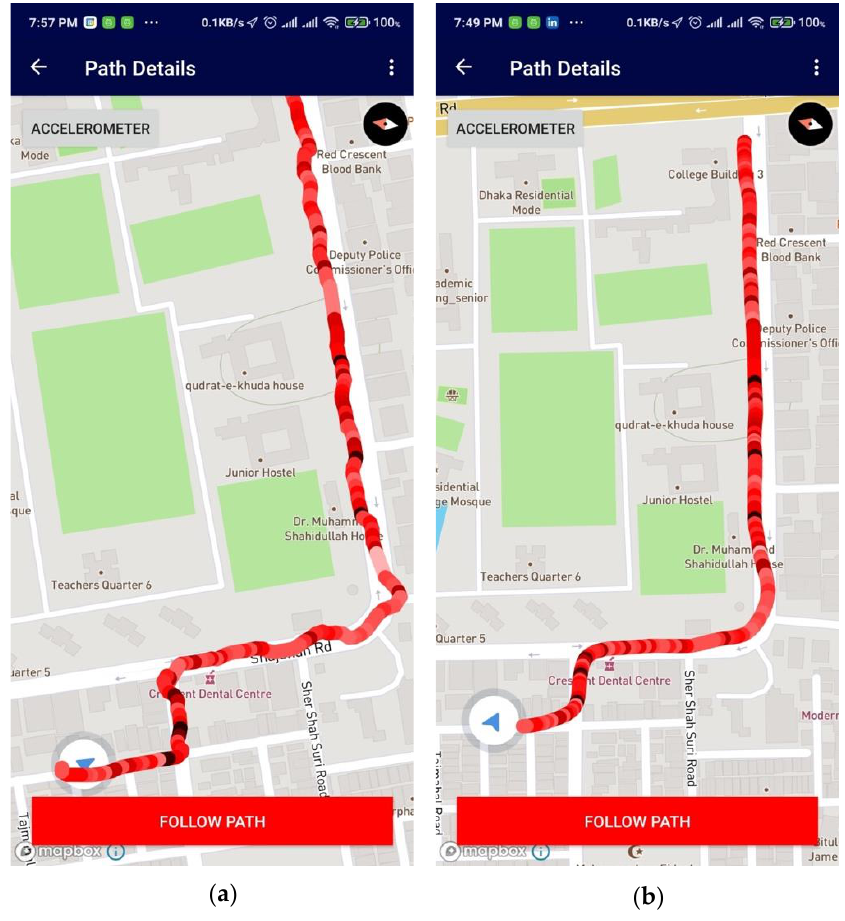
Figure 7. Route map created without using any filter ( a ) and after using the Kalman filter ( b ).